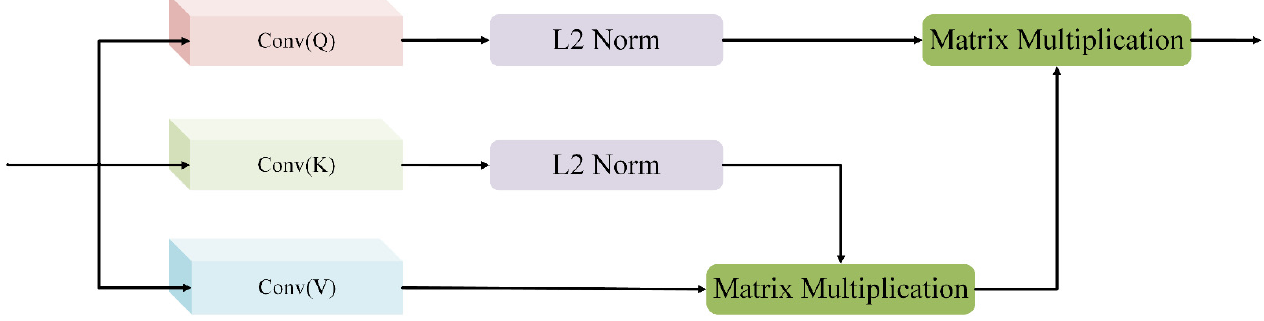
Figure 5. The linear attention.